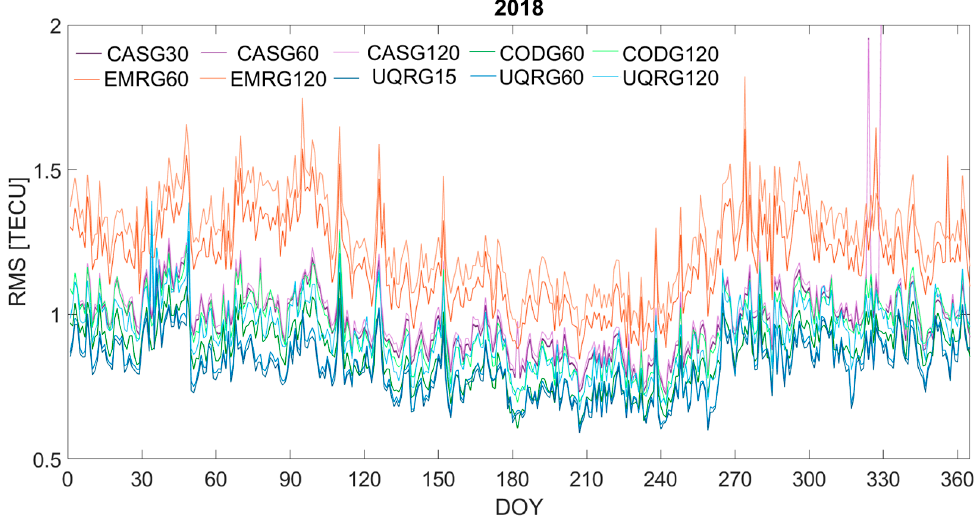
Figure 4. Daily RMS distribution from GNSS-STEC comparisons for all analyzed GIMs in 2018. Table 2. Annual RMS from GNSS-STEC comparisons for all analyzed GIMs in 2018. GIM ID